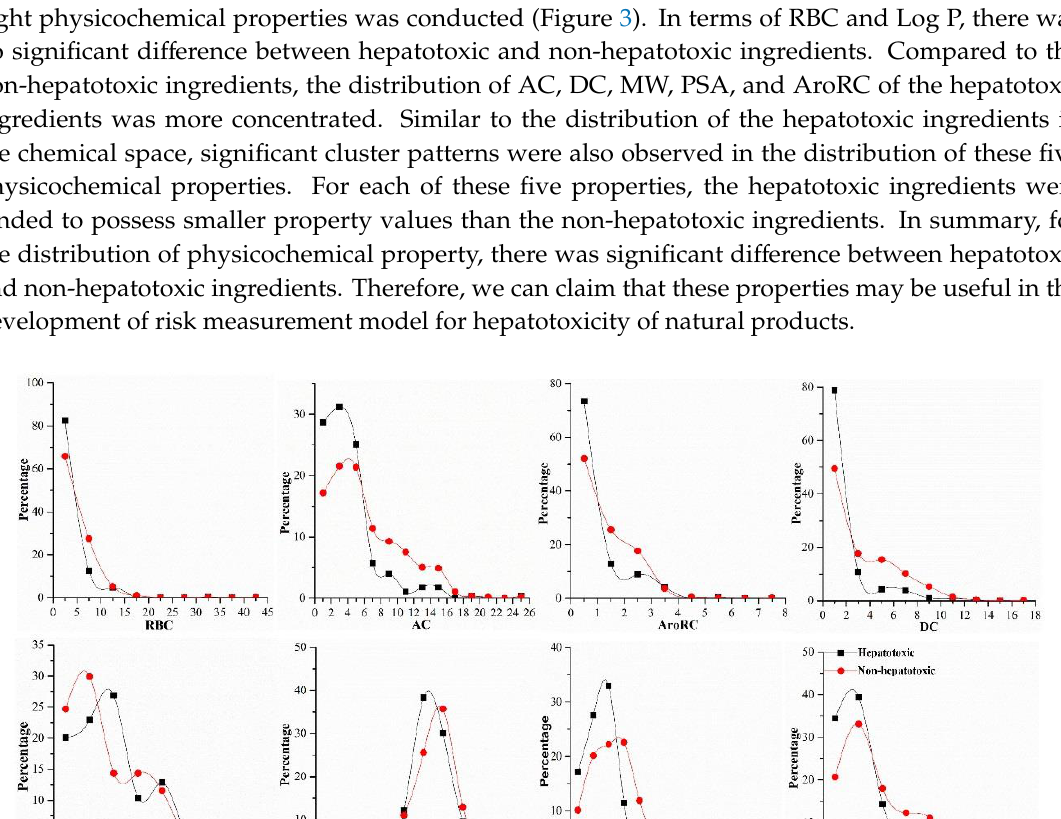
Table 4. Eight sub-categories with higher frequency of hepatotoxicity.